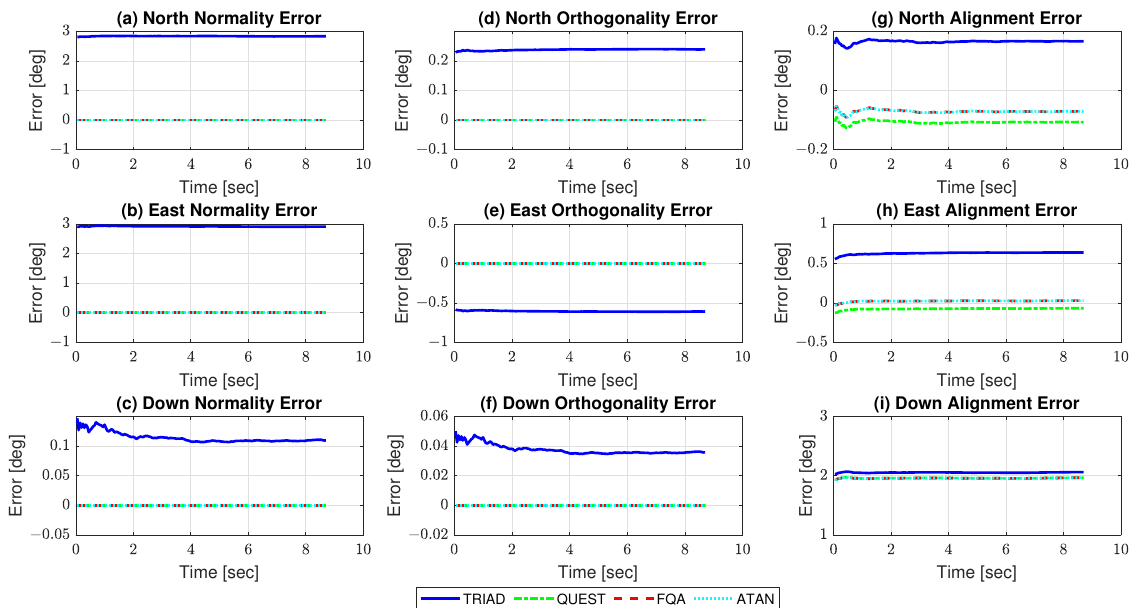
Figure 4. Estimated DCM residual errors in experimental